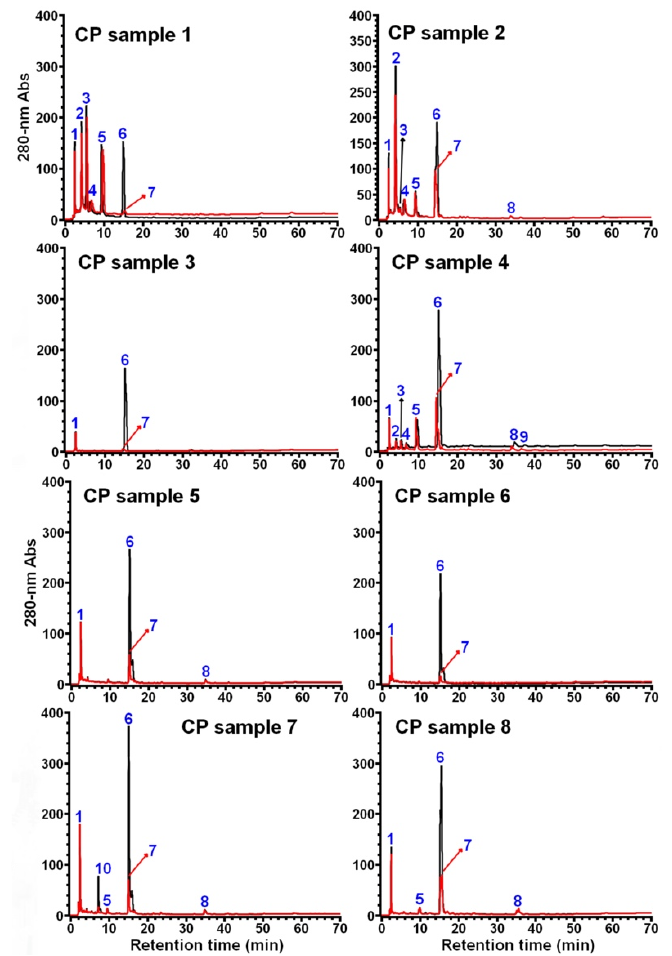
Figure 1. HPLC analysis of aqueous extract of 8 different CP samples. The chromatograms in black and in red were obtained based on a direct injection of the samples without (or before) and with (or after) CHCl 3 treatment, respectively.